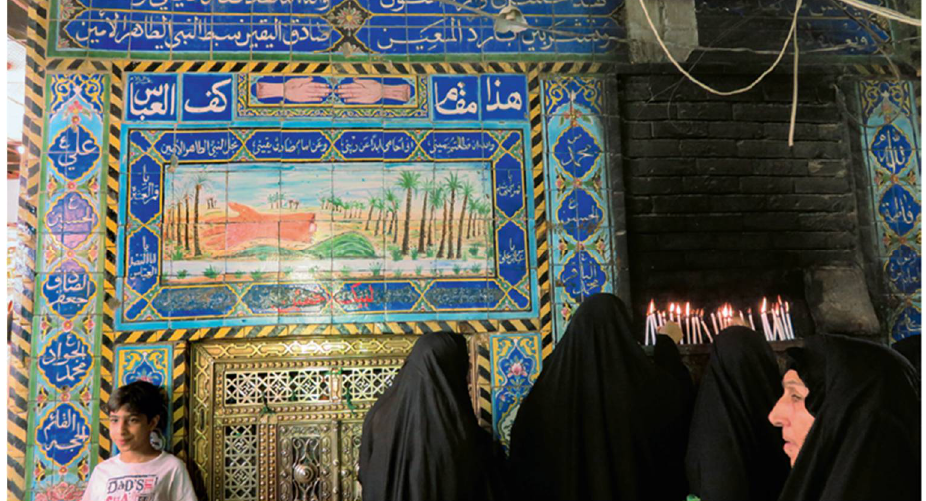
Figure 8. The maq¯aam of ‘Abb¯as’ right hand in Karbala. Source: Sepideh Parapajouh, “The Figure 8. The maqāam of ‘Abbās’ right hand in Karbala. Source: Sepideh Parapajouh, “The Topography of Corporal Relics in Twelver Shi ʿ ism: Some Anthropological Reflections on the Places of Ziyāra”, Journal of Material Cultures in the Muslim World , 1 (Parapajouh 2020): 199–225 at p. 215. accessed on 1 October 2021.